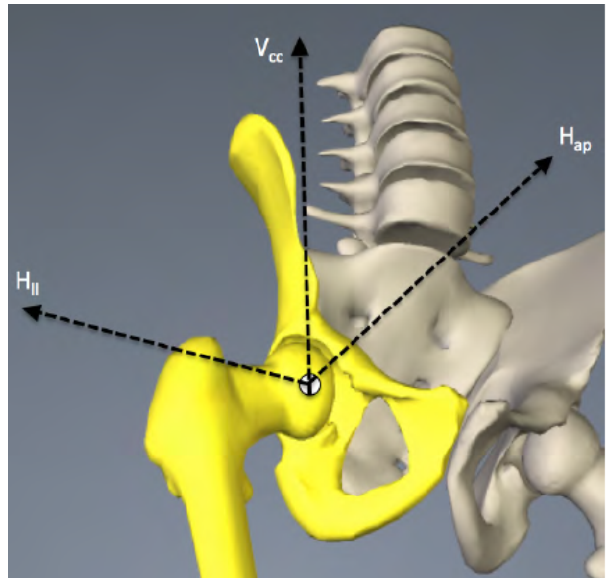
Figure 1. Reference axes on the hip joint. H ll stands for the horizontal axis (lateral femoral), V cc stands for the vertical axis (craniocaudal), H ap stands for the horizontal axis (anteroposterior).